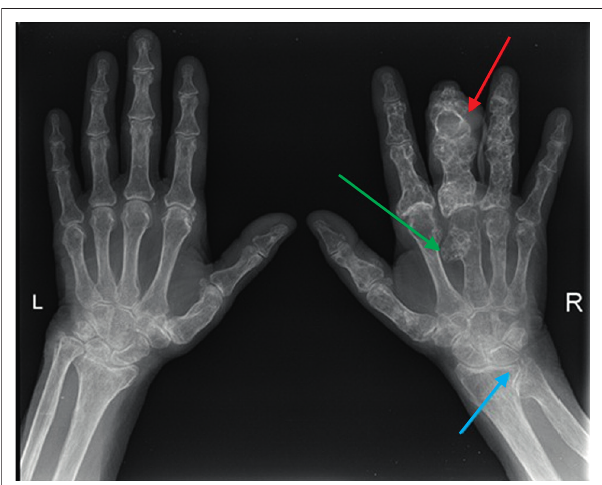
FIGURE 5: Anteroposterior radiograph of both hands demonstrates multiple enchondromas of the metacarpals and phalynges with expansile growth in the third middle phalynx (red arrow) of the right hand, and exophytic growth of the third metacarpal enchondroma (green arrow). Note the unilateral nature of the pathology as well as Madelung’s deformity of the right wrist (blue